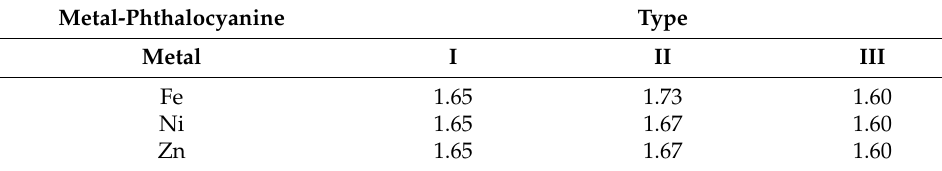
Table 7. Ovality.